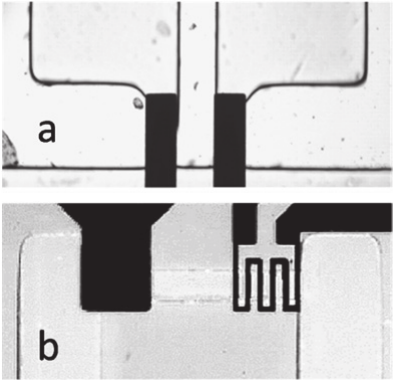
Fig. 15: Microscopic images of ETµP structures on thin glass according to Figures 12b and 12a (dark: 100 nm thick platinum structures; light gray: 60 µm thick polymer-wall structures; light areas: fluid channels). The central pump channels were 250 µm